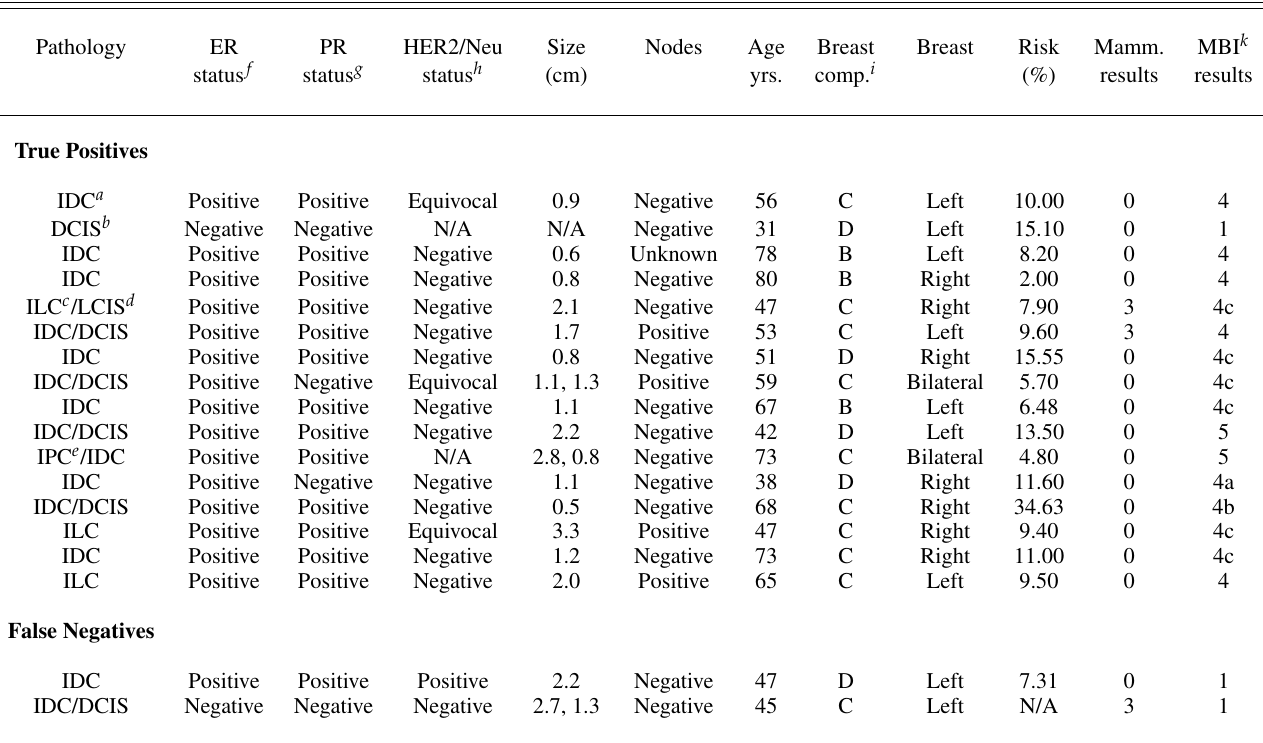
Table 4. Tumor characteristics of cancers; true positives were detected on diagnostic MBI; false negatives were interval cancers occurring at 332 and 218 days after MBI examination